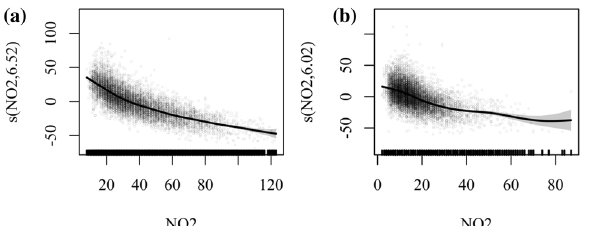
Fig. 4 Impacts of NO on O in GAM in Tongling ( a ) and Huangshan 2 3 ( b ). The Y-axis in each subplot represents the smoothing function term for each predictor, and the numbers in brackets represent degrees of freedom. Black markers on the X-axis represent the dis- tribution of the predictors (corresponding to the scatter points in the